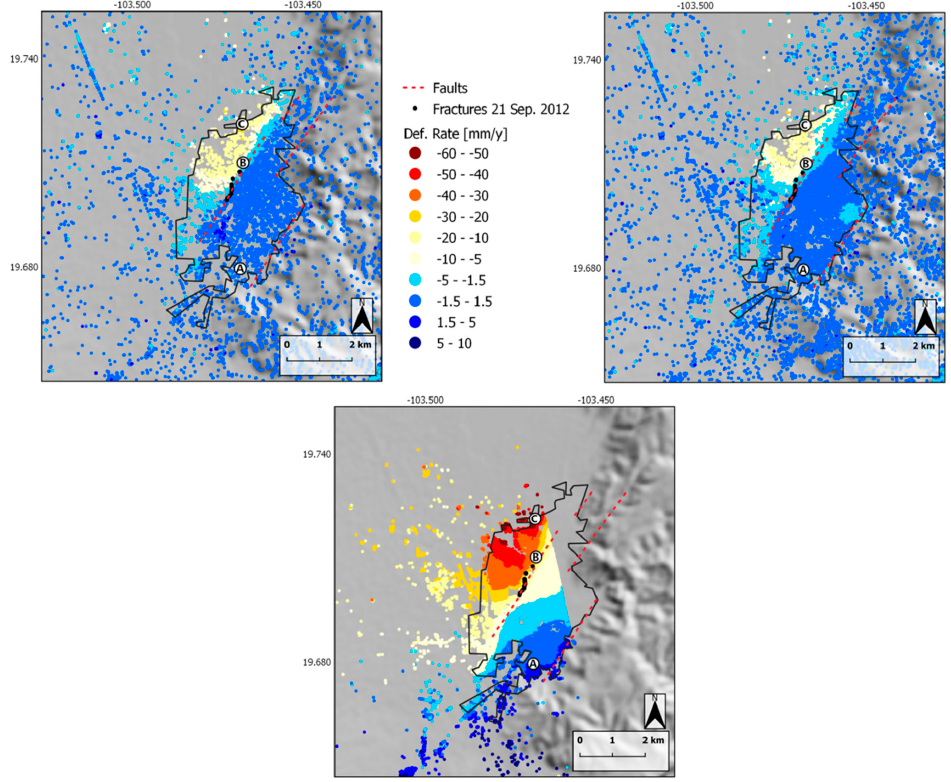
Figure 3. Maps of the deformation rate from the ENV dataset (2003–2010 time period descending and ascending paths, upper panels on the left and right, respectively) and from the CSK dataset (2011–2015 time period ascending path, lower panel). Both the ENV and CSK datasets were processed using the IPTA multi-baseline technique. The white circles indicate three selected sites individuating different displacements rates: (A) stable or light-positive ground velocities (toward the satellite); (B) intermediate values of negative velocities (moving away from the satellite), near the fractured area; (C) highest values of negative ground velocities. A ground urban survey performed in CG in November 2012 assessed the deformations and associated fractures (black points alignment on the maps) that occurred on 21 September 2012